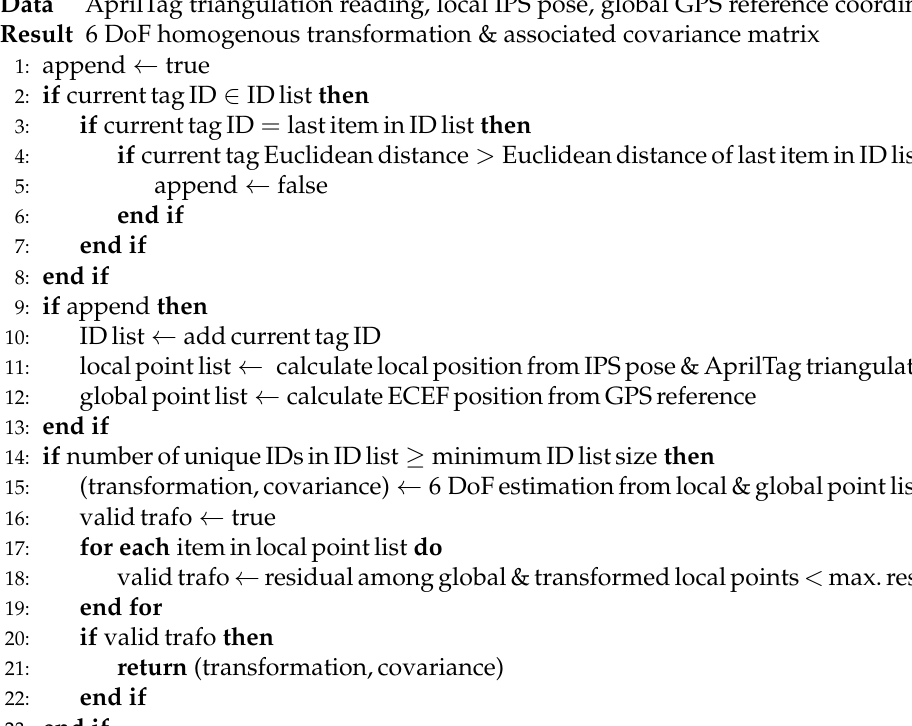
Algorithm 1 Selection logic for switching from local to global navigation